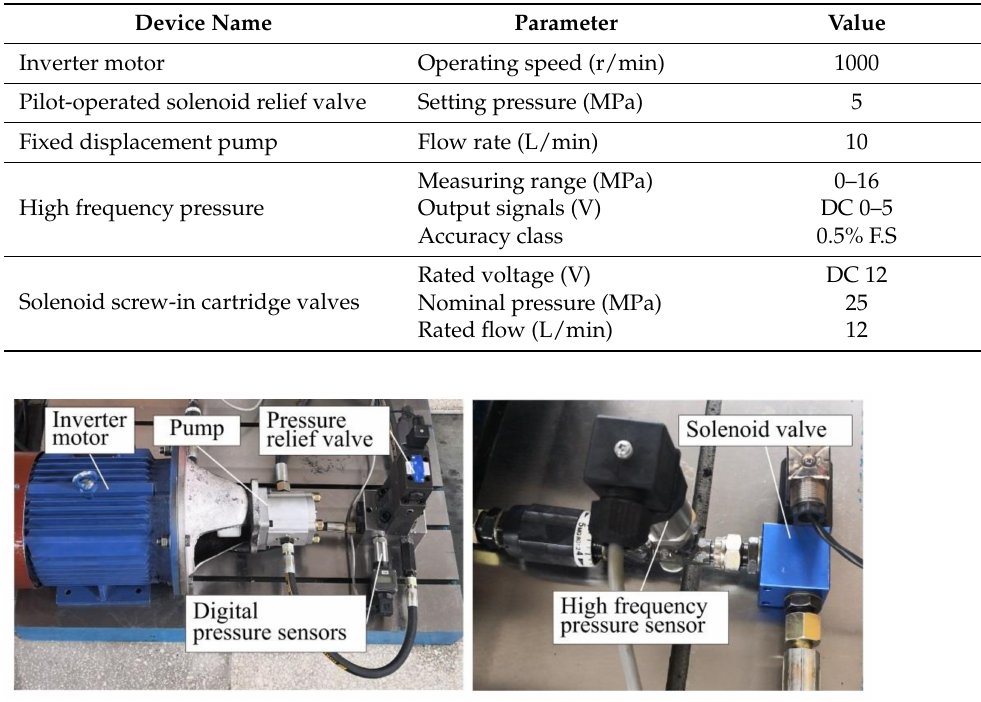
Figure 8. Overview of the experimental prototype.